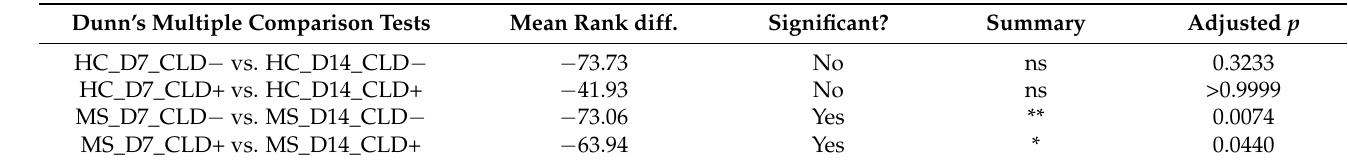
Table 4. Comparison of CLD exposure effects on TNF- α secretion by PBMCs from RRMS patients and HCs on days 7 and